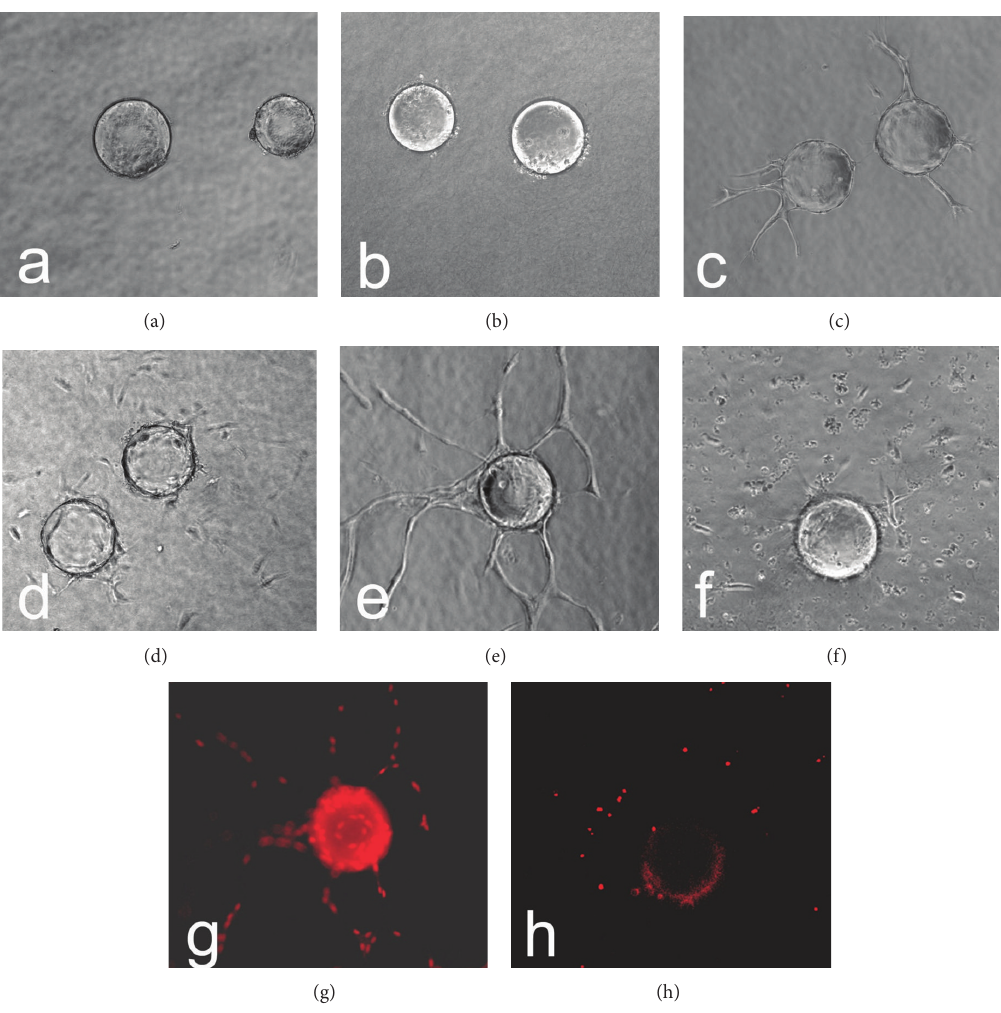
Figure 5: Fibrin gels (a, c, e, g) and collagen gels (b, d, f, h) differentially regulated HDMEC response to VEGF (30ng/mL) and bFGF (25ng/mL). Without the addition of angiogenesis factors, little or no sprout formation, invasion, or migration of HDMEC occurred either in fibrin gel (a) or in collagen gel (b). In the presence of VEGF (30 ng/mL) and bFGF (25ng/mL), HDMEC formed capillary sprouts which invaded and migrated into fibrin gel within 48hr (c). In contrast, in collagen gel in the presence of VEGF (30 ng/mL) and bFGF (25ng/mL), HDMEC invaded and migrated into the gel individually without forming capillary sprouts (d). After 5 days, the capillary sprouts in fibrin elongated and branched (e). IF staining revealed that the capillary sprouts in fibrin were formed by multiple, lineal aligned cells (g). After 5 days, HDMEC randomly migrated into collagen gel without forming capillary sprouts (f). IF staining revealed that the nuclei were randomly distributed in collagen gel (h) (100x